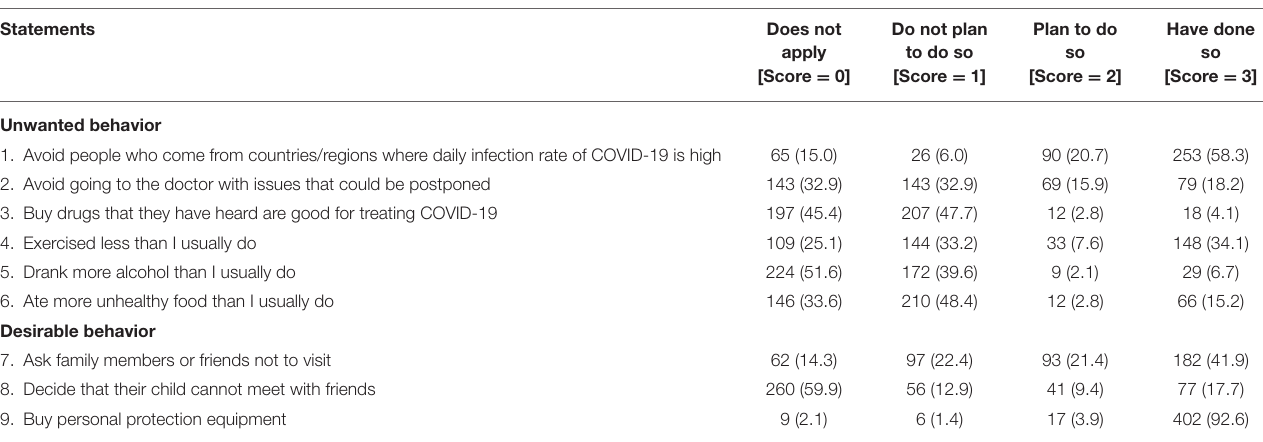
TABLE 6 | Behaviors during the pandemic and the MCO ( n =